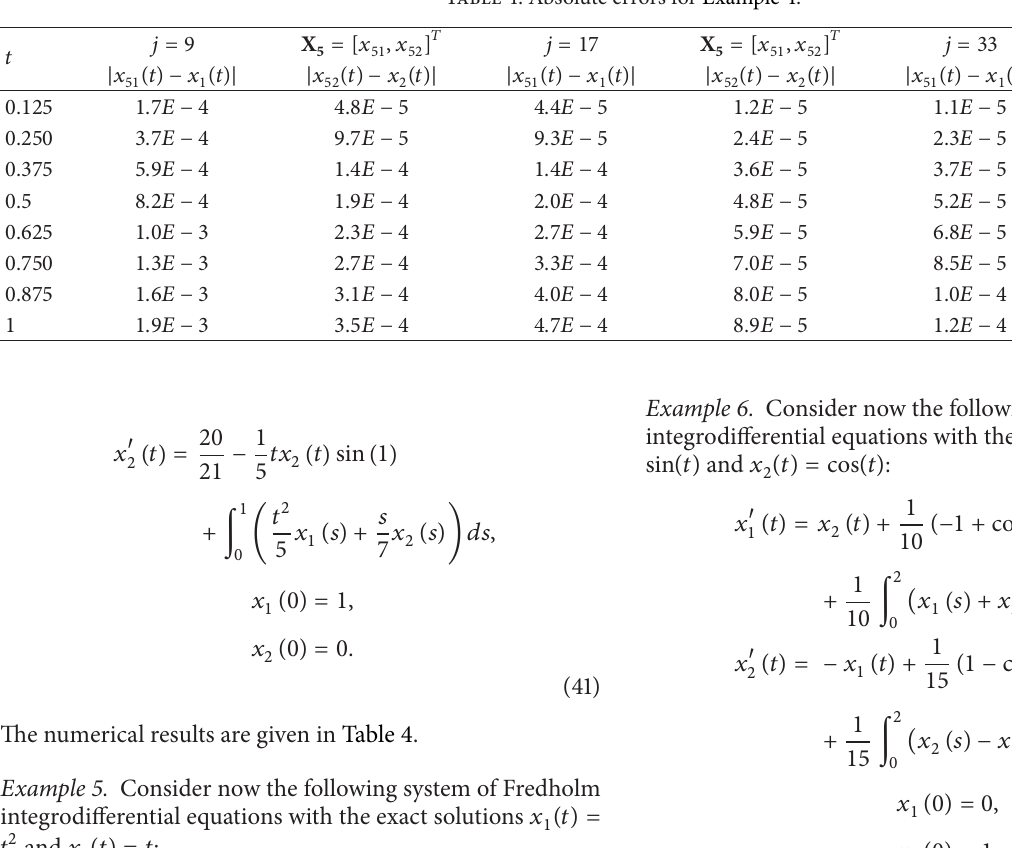
Table 4: Absolute errors for Example